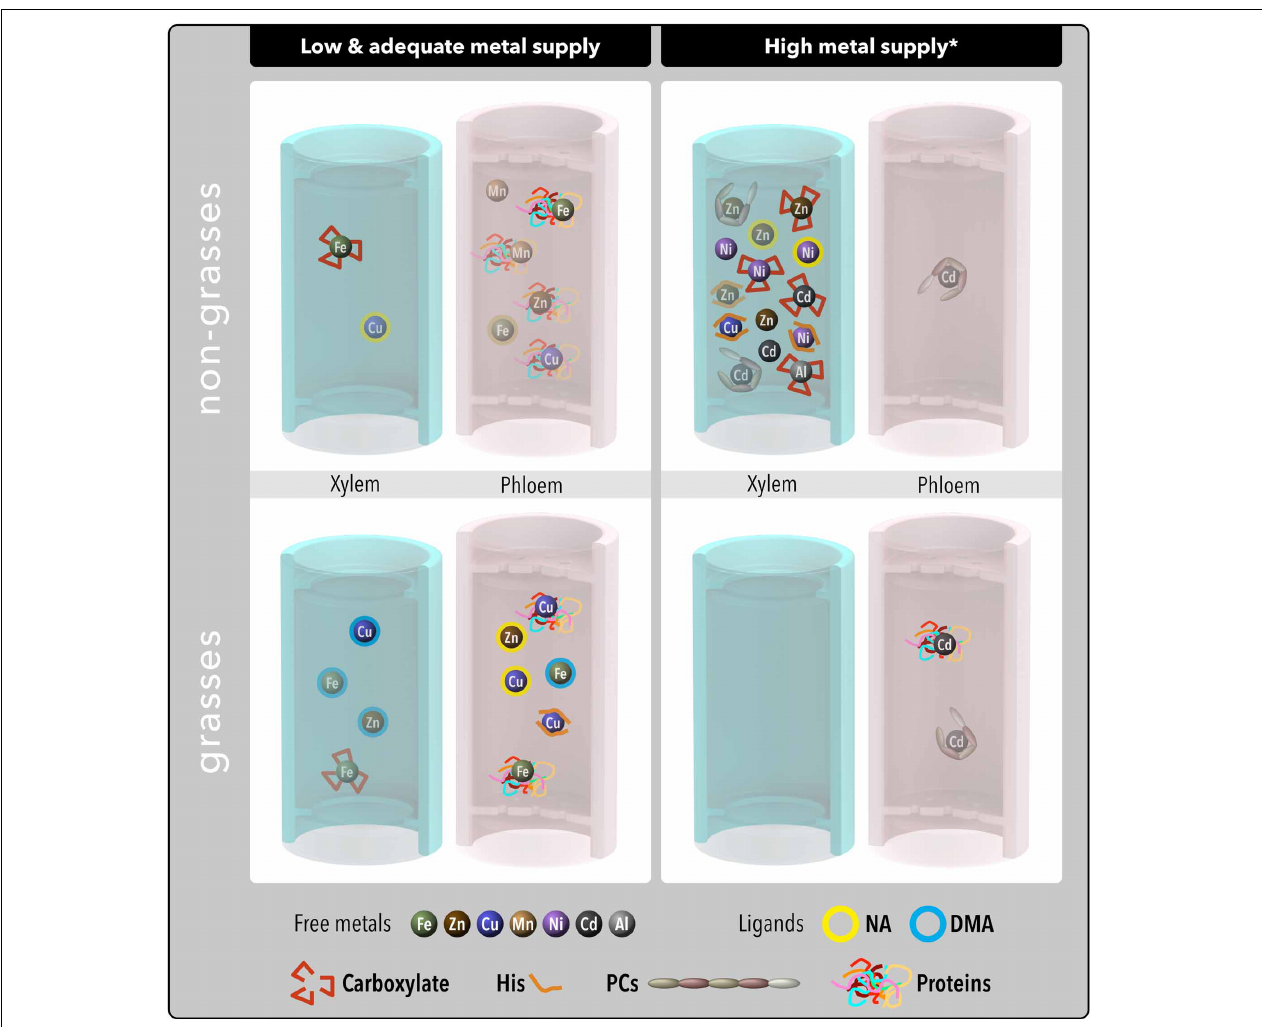
carboxylates (e.g., citrate), histidine (His), phytochelatins (PCs) and proteins. Putative metal species proposed to occur in plant fluids as supported by strong evidence from indirect approaches (e.g., molecular biology and others) are shown with faded symbols. ∗ Most of the data with high metal supply have been described in metal hyper-accumulator plant